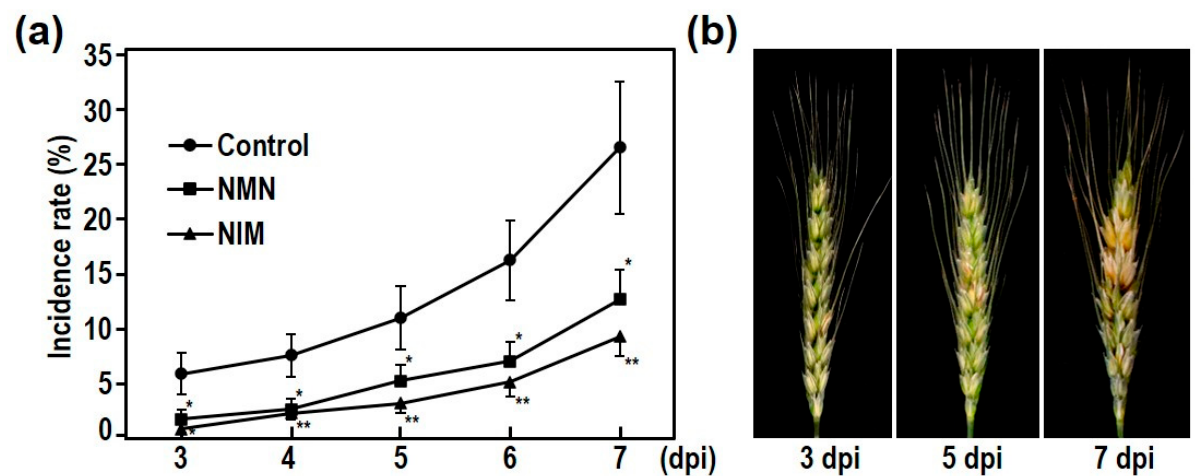
Figure 1. Disease incidence of Fusarium head blight (FHB) gradually increased from 3 dpi to 7 dpi. ( a ) The incidence of FHB disease on spikes of wheat cultivar USU-Apogee from 3 to 7 dpi. These spikes were sprayed with water, NMN, or NIM before inoculation. Each bar represents standard error ( n = 12). Results of student’s t-test are shown: * p < 0.05, ** p < 0.01. ( b ) Representative photographs of symptom development in the water-treated control spikes at 3, 5, and 7 dpi.